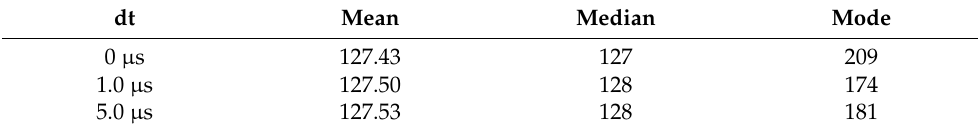
Table 3. Statistics data of Figure 2.